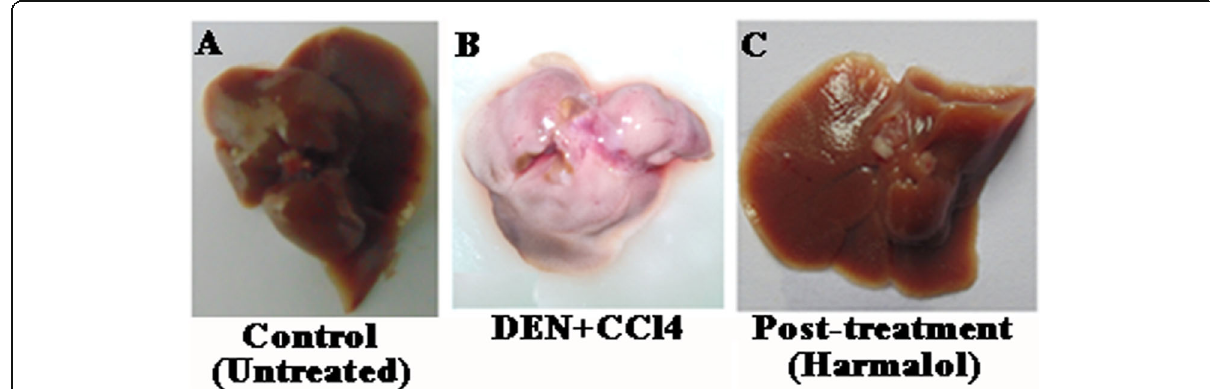
Fig. 3 Photographic images of gross liver in different groups of experimental mice. a The liver of control mice. b After the 21st week of DEN+ CCl 4 -injected mice (group V). c Harmalol post-treated